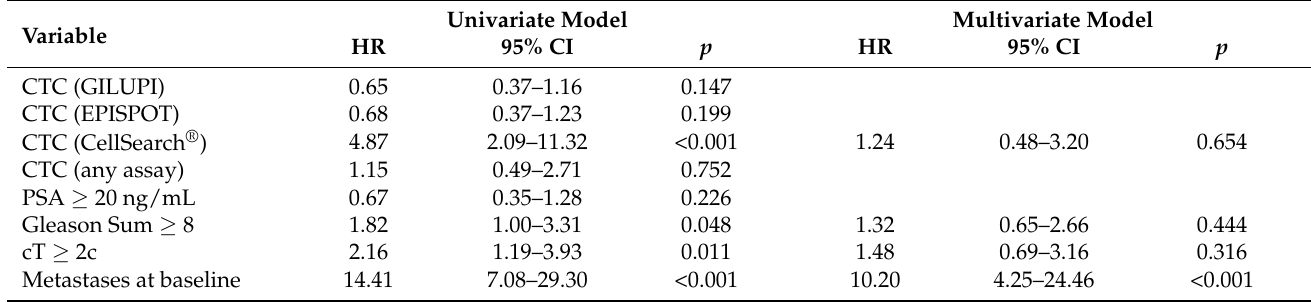
Table 6. Baseline CTC counts detected using the GILUPI CellCollector, EPISPOT assay and Cell- Search ® system and clinical characteristics of 85 patients with localized PCa at baseline, according to survival during the follow-up period.